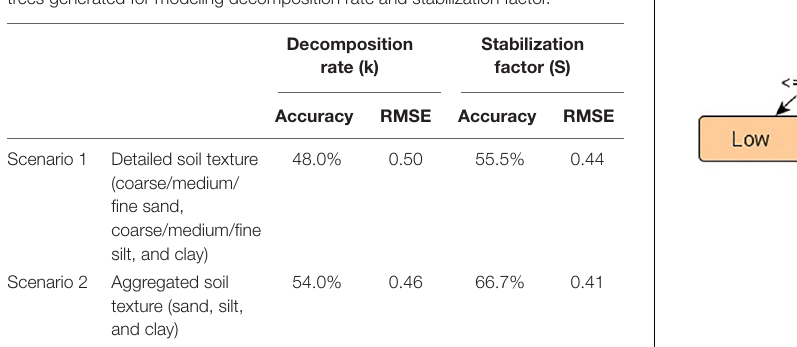
TABLE 2 | Predictive performance (accuracy and RMSE) of the four classification trees generated for modeling decomposition rate and stabilization factor.